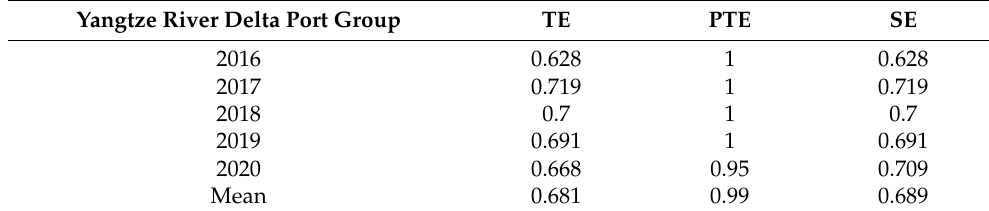
Table 4. Comprehensive Efficiency of the Yangtze River Delta port group from 2016 to 2020.